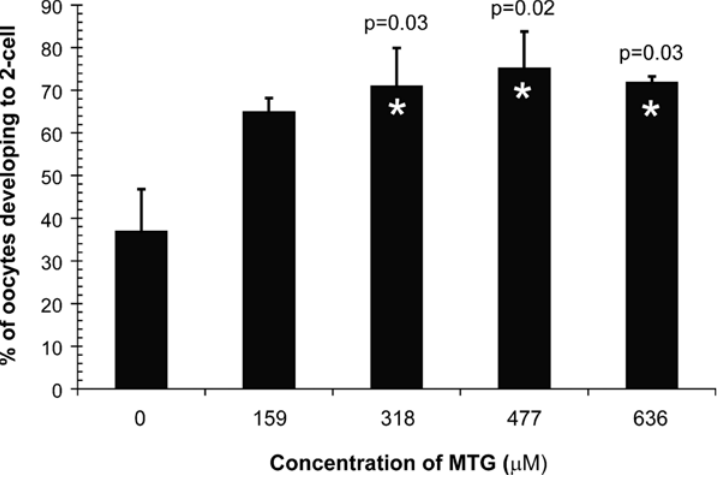
Figure 2. Doseresponseofmonothioglyceroladditiontomousespermcryopreservationmedia. Sperm were collected from 6 C57BL/6J males. To reduce male-to-male variability, 3 pools of sperm were created by combining 2 males each. The samples were split 5 ways and the sperm were cryopreserved in the concentrations of monothioglycerol (MTG) illustrated on the x-axis. The cryopreserved sperm were thawed, placed into MVF and incubated for 60 min prior to the addition of cumulus oocyte masses from two superovulated C57BL/6J females (mean 6 standard deviation; 50 6 22 oocytes/IVF). Differences among the treatments were determined using ANOVA and preplanned comparisons to the control of no MTG using Dunnett’s